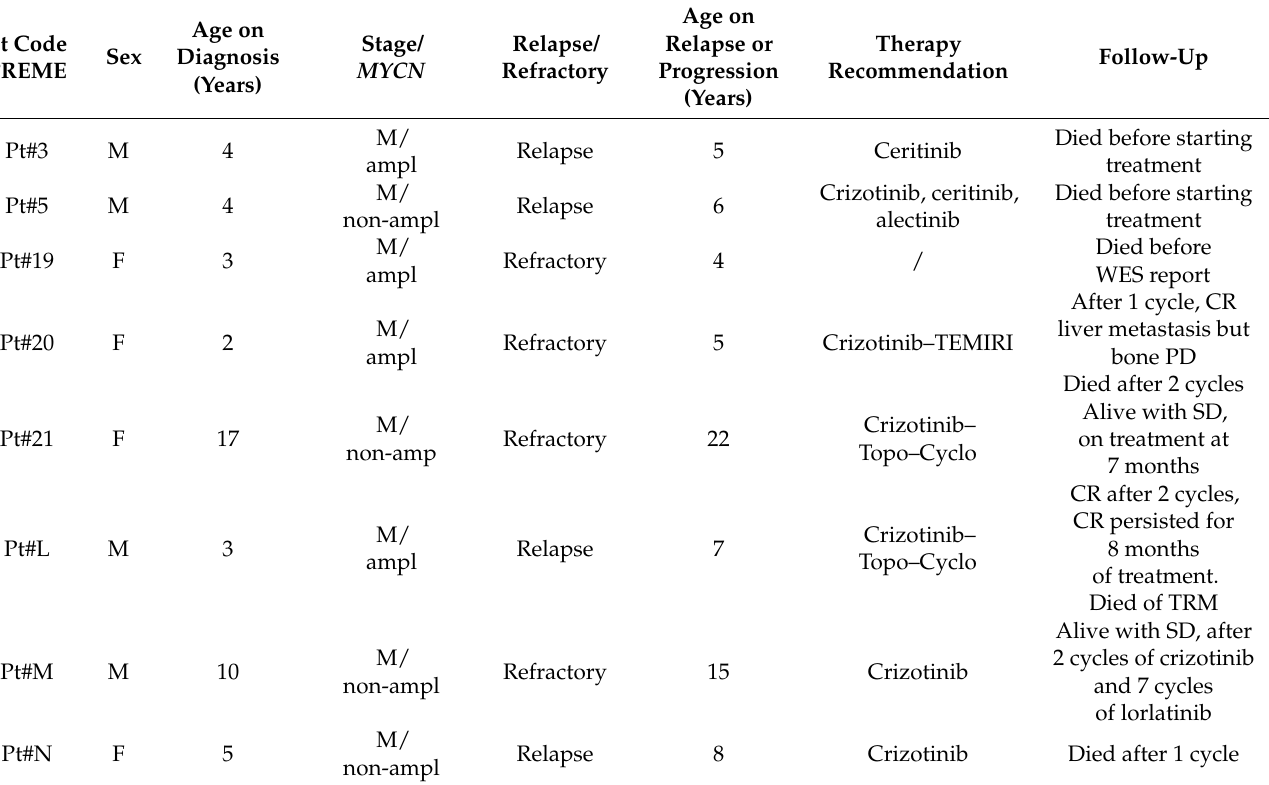
Table 1. Characteristics of patients and targeted treatment recommendations for ALK